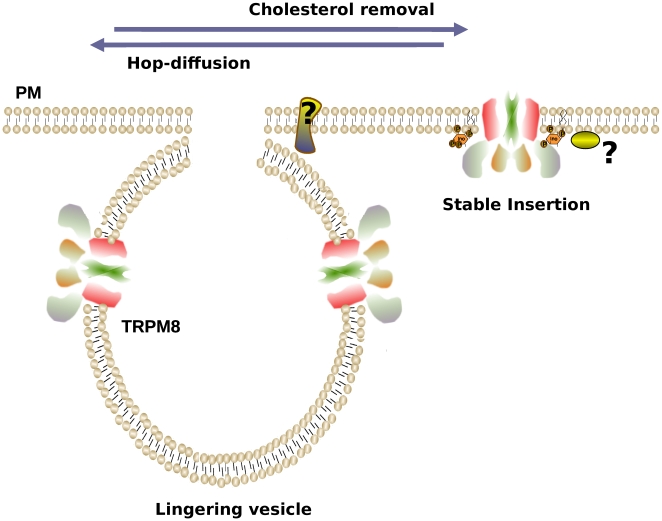
Model for hop-diffusion/stabilization of TRPM8 channels.According to our results an important population of TRPM8 channels undergo hop-diffusion. This behavior can be changed to extreme opposite conditions when membrane composition is altered. MβCD treatments are sufficient to stabilize the channels at the plasma membrane. We expect that hop diffusing vesicles containing TRPM8 channels are stabilized at the membrane, tethered but not fully fused, in a so called fuse-and-linger mode.